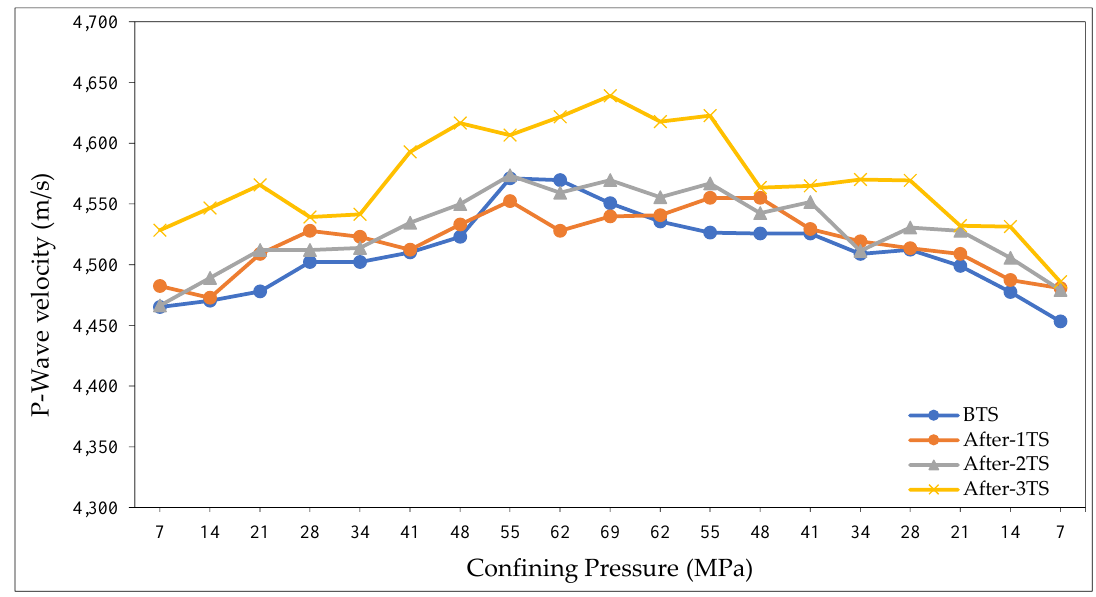
Figure 6. P-wave velocity results of EF#5 at different confining pressures before and after thermal shock.